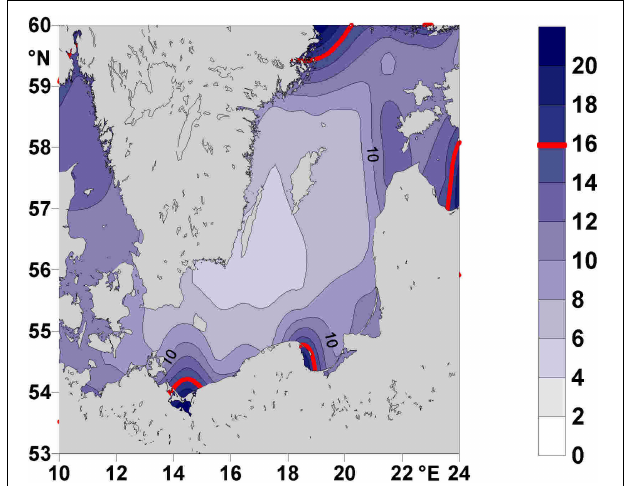
FIGURE 2 | Climatic mean molar N:P ratios during January and February from 1928 to 2005 in the upper 30 m of the Baltic Proper, based on monitoring data compiled by Feistel et al. (2008). The red line indicates the Redfield ratio of